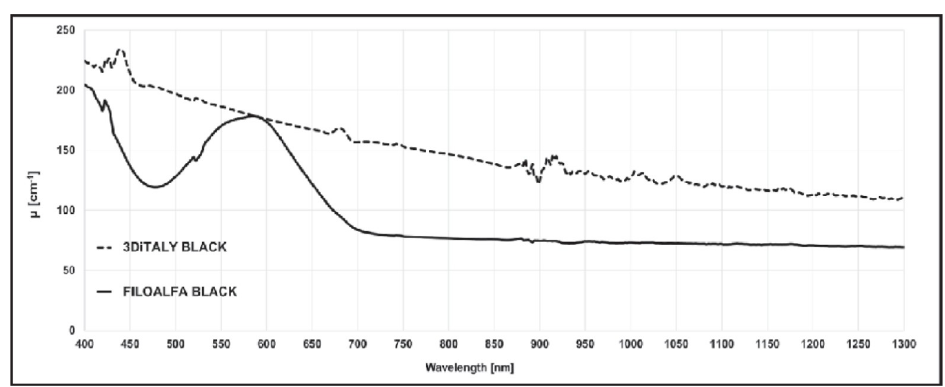
Fig 2. Extinction coefficient μ spectra in the wavelength range 400–1300 nm for two black PLA filaments (3DiTALY, dashed line; FILOALFA solid line).